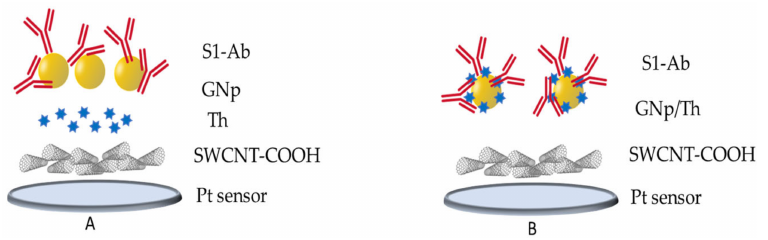
Figure 1. The LBL chemistry design ( A ) and hybrid LBL chemistry design ( B